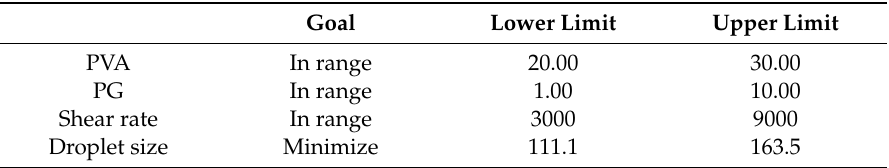
Table 6. Constraints of numerical optimization.